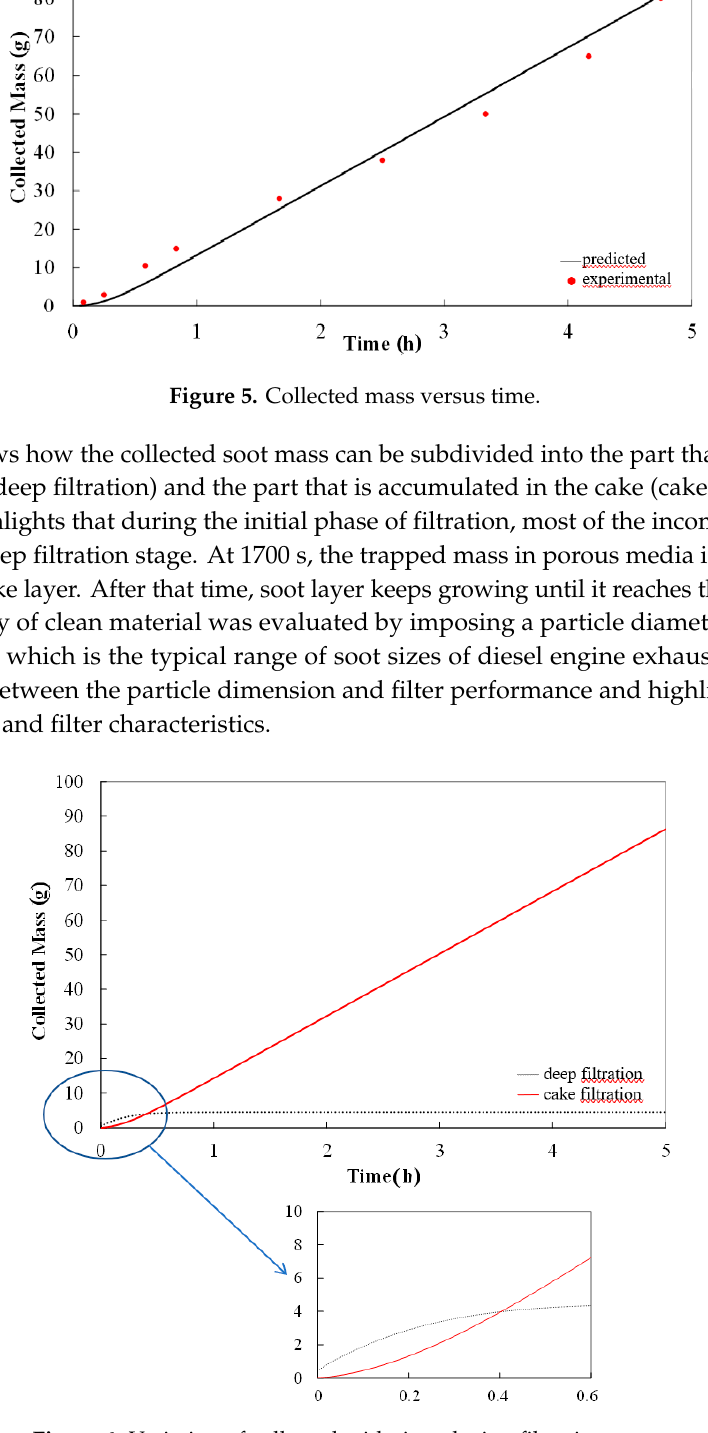
Figure 7. Variation of filter efficiency with particle size. The trend in the upper part of the figure highlights that the worst filtering condition is reached for the 350 nm diameter particle for which the initial collection efficiency of the device is about 0.61. The curve was obtained by assuming that Brownian diffusion and interception are independent each other. In the bottom part of the plot, two curves are shown, one represents the efficiency obtained by accounting only for the diffusion effect; the other was obtained by considering only the interception mechanism. Their effect on soot size is opposite: As particle diameter increases, diffusion coefficient and then Brownian diffusion efficiency decreases. In the meantime, interception efficiency increases. The evolution of material properties was simulated accounting for the variation of porosity and permeability of the porous media with time in correspondence of the progress in accumulation process; in the model, the porous medium was divided into slabs. The mass in every slab volume is computed by the local efficiency. Figure 8 shows the evolution with time of the mass accumulated into each slab (15 slabs were considered). The traces, parametrized with time (its variation is between 0 s and 3600 s, with steps of 600 s), highlight the difference in the behavior of each slab as function of the distance from the